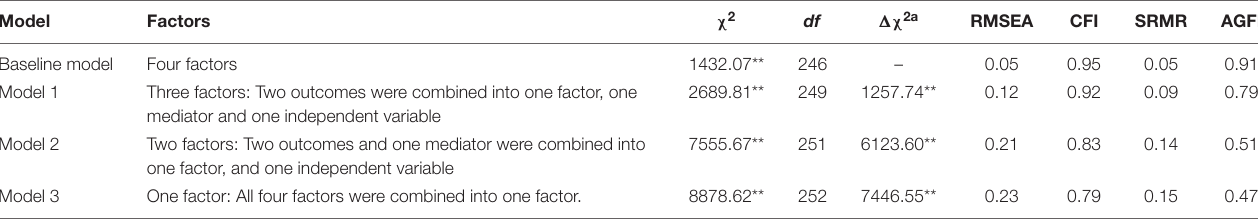
TABLE 1 | Comparison of measurement